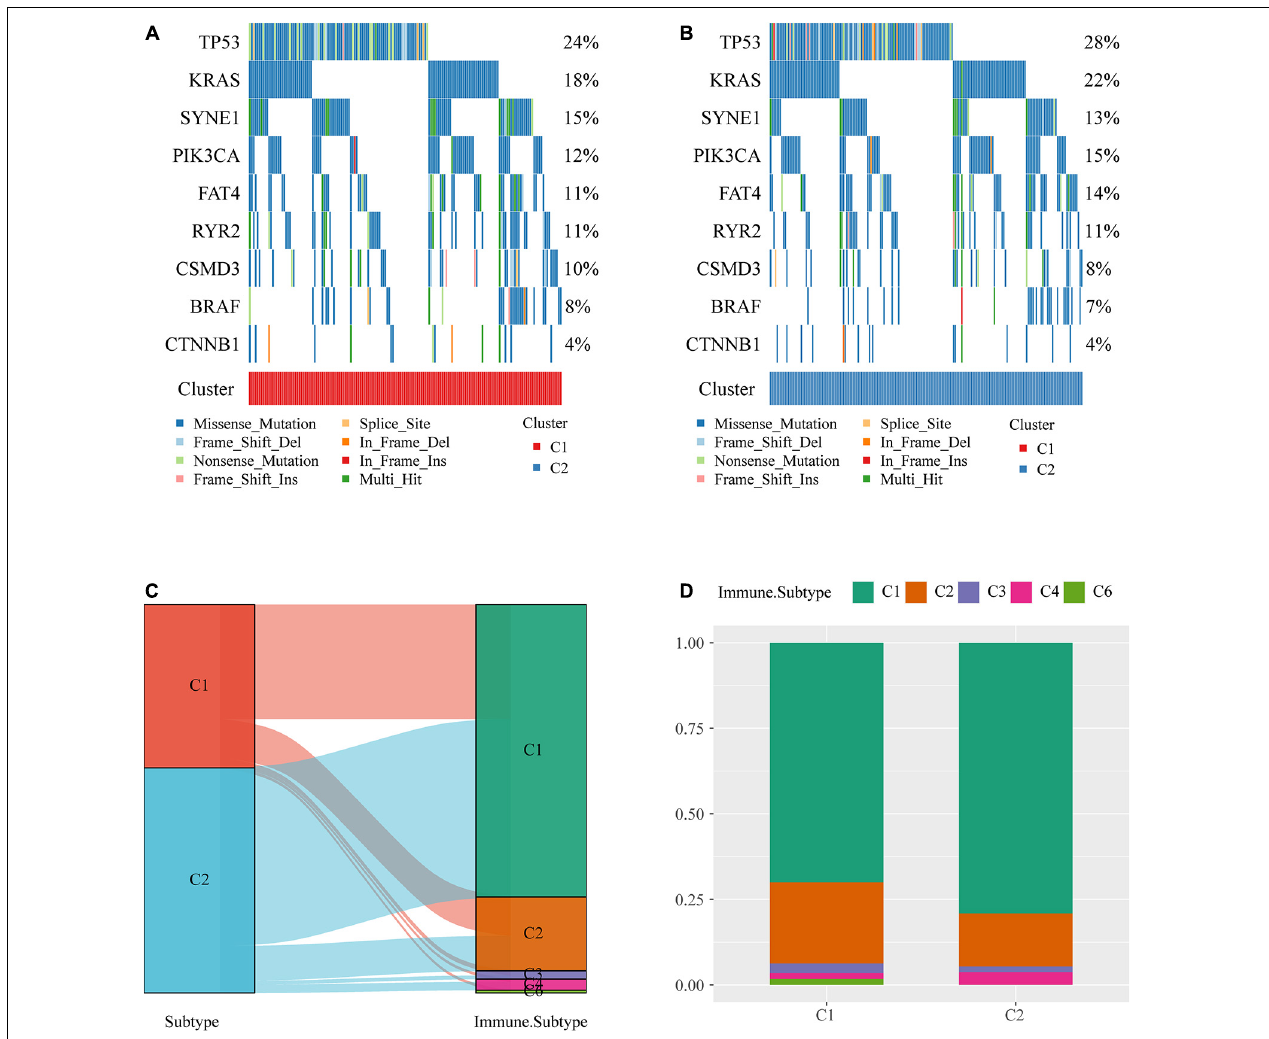
FIGURE 3 | Comparison of mutations among molecular subtypes and existing immune subtypes. (A) Key gene mutation map of the molecular subtype C1. (B) Key gene mutation map of the molecular subtype C2. (C) Sankey diagrams of the study molecular subtypes and existing molecular subtypes. (D) Distribution of existing molecular subtypes within our molecular